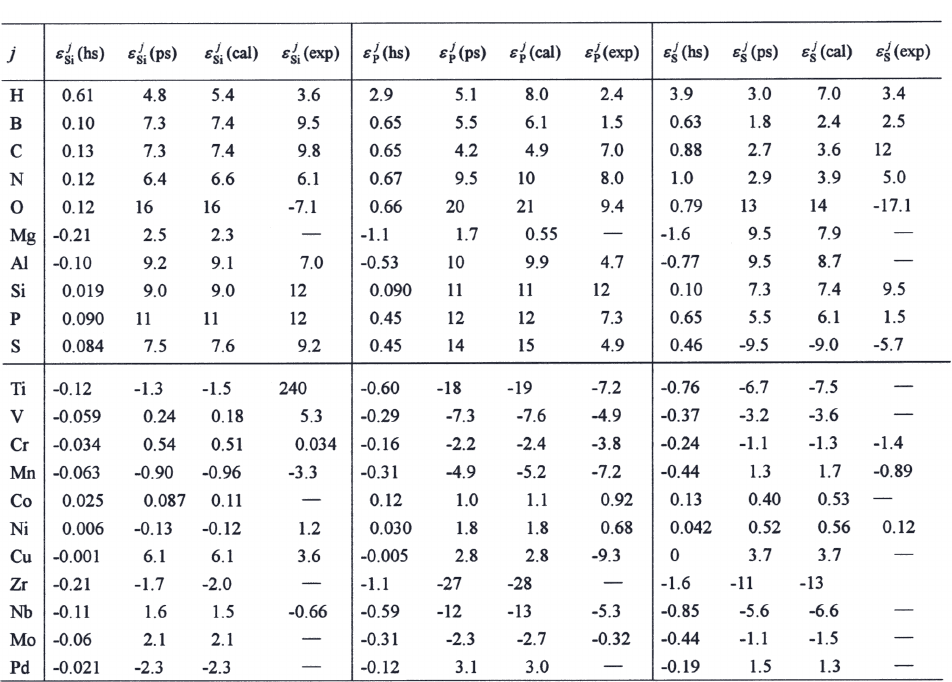
Table 2. Interaction parameters for carbon, nitrogen and oxygen in iron solutions with available experimental data at 1873K.